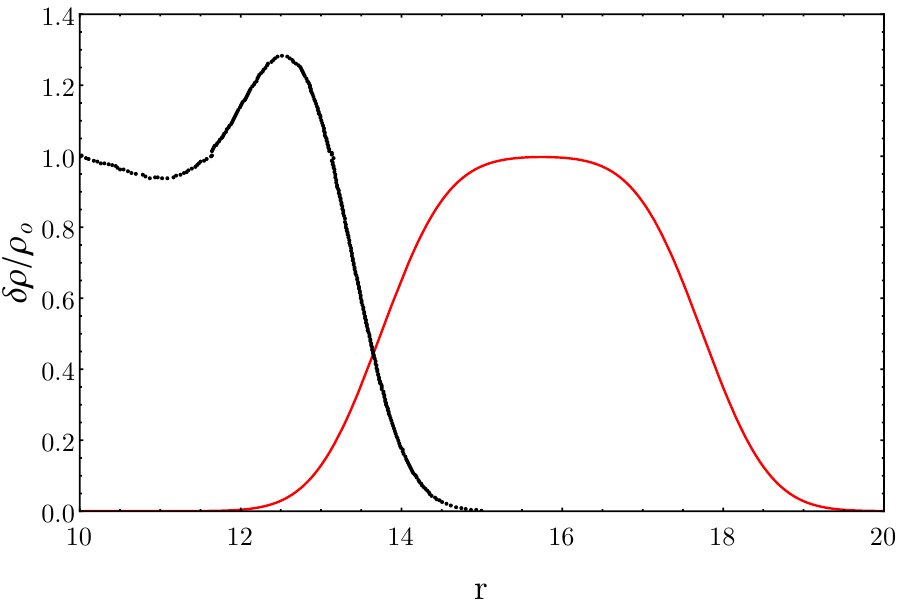
Figure 11 . Density profile of the ground state (black dots) [49, 50] and of the large charged excitation with t = 8 (red line) for ν = 1 / 3 . Both profiles are independent of the number N of electrons, up to a shift on the r axis ( N = 64